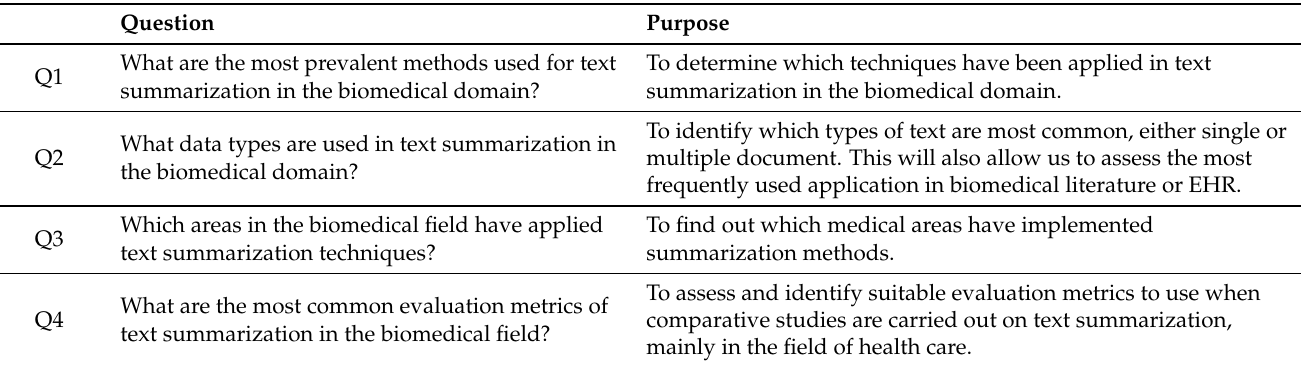
Table 1. Research